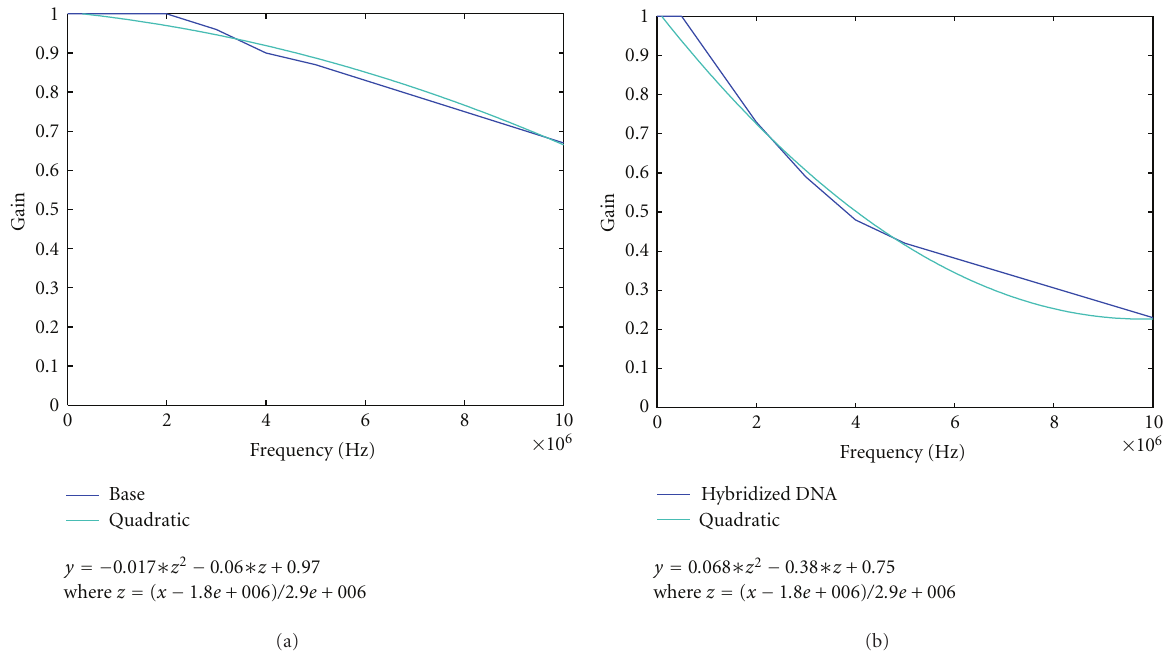
Figure 7: (a) and (b) represent the curve fitting technique applied on the 70 Ω Base and Hybridized sensor, respectively. Equations underneath respective figures represent the gain-frequency relationship. Using the above equations, the capacitance for the sensor with known resistance was calculated and it resulted in a value comparable to the designed capacitance. Table 1 represents the designed and calculated capacitance (from above equations).